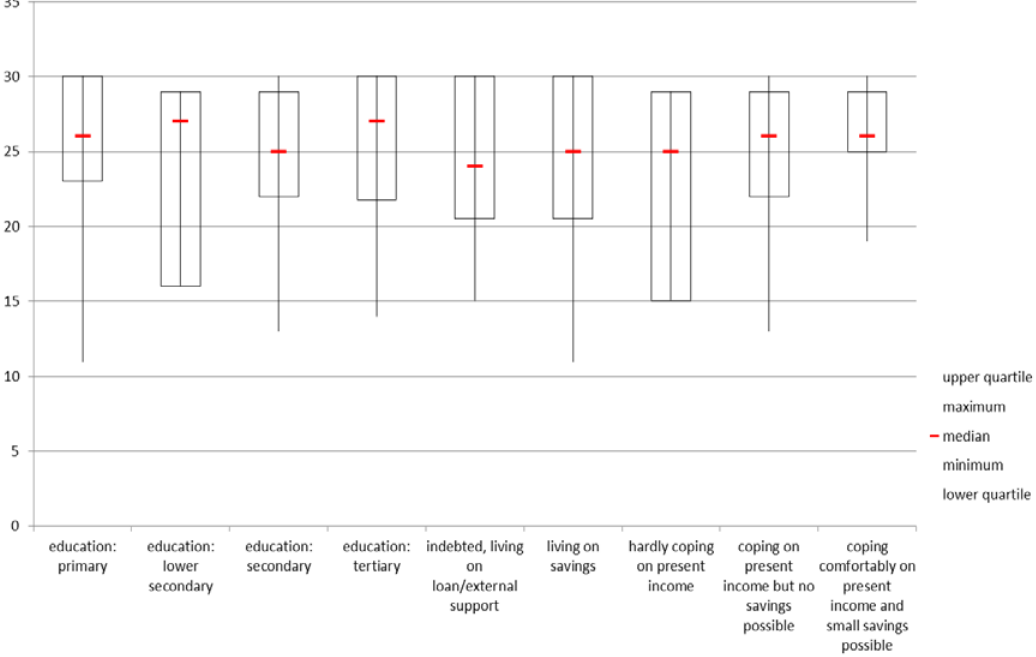
Figure 2. Basic distribution of the work-family balance scores across social characteristics, N = 383.